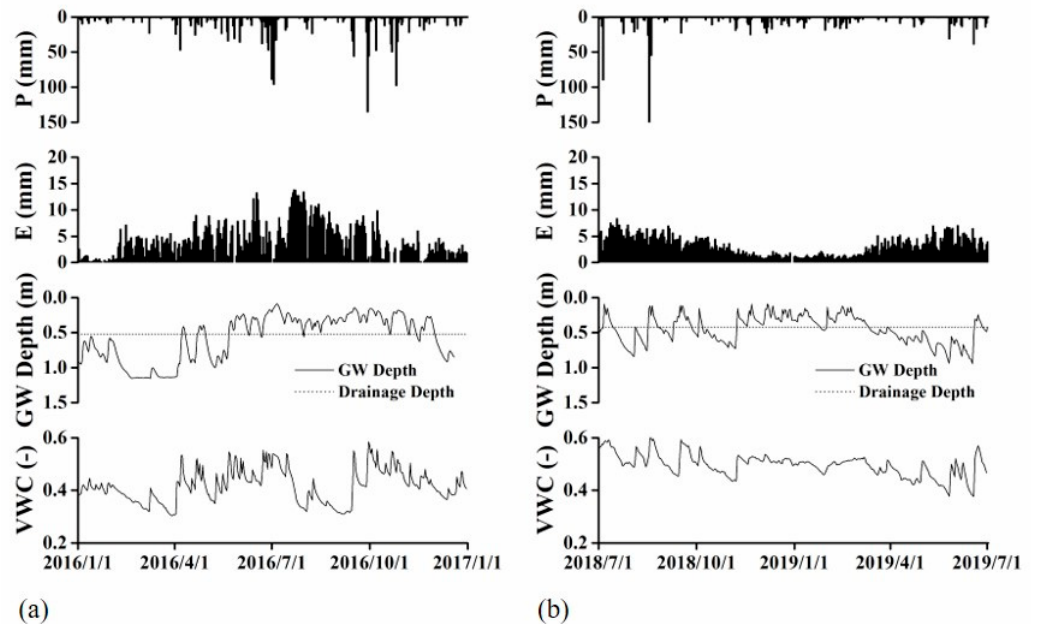
Figure 3. Daily rainfall depth ( P ), evaporation ( E ), groundwater depth (GW depth), and volumetric soil water content ( VWC ) at the 10 cm depth below the ground surface: ( a ) in the HQW site from 1 January 2016 to 31 December 2016, ( b ) in the BTQ site from 1 July 2018 to 30 June